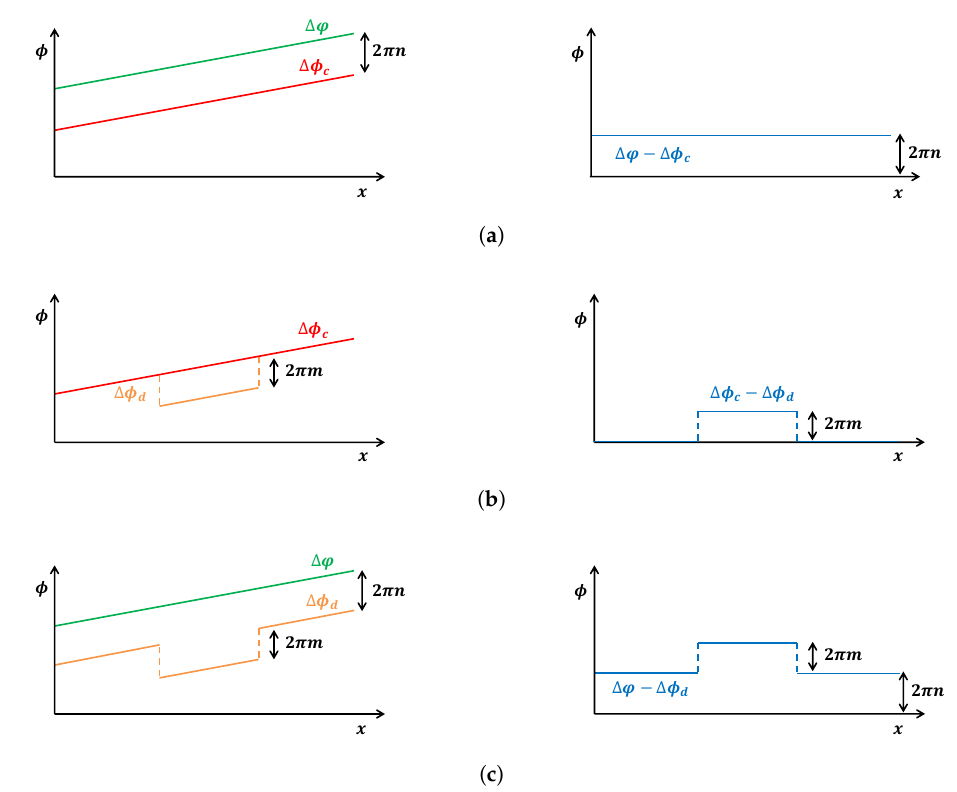
Figure 5. Diagrams of the validation procedure for a one-dimensional simplified interferogram. ( a ) If the connected InSAR phase ∆ φ c is subtracted from the split-band phase ∆ ϕ , the difference gives an offset 2 π n . ( b ) If a region of the one-dimensional interferogram is disconnected, an offset 2 π m is introduced between the connected phase ∆ φ c and the disconnected InSAR phase ∆ φ d . ( c ) If the disconnected InSAR phase is subtracted from the split-band phase, the relative offset 2 π m between the disconnected regions remains the same as in case ( b ).